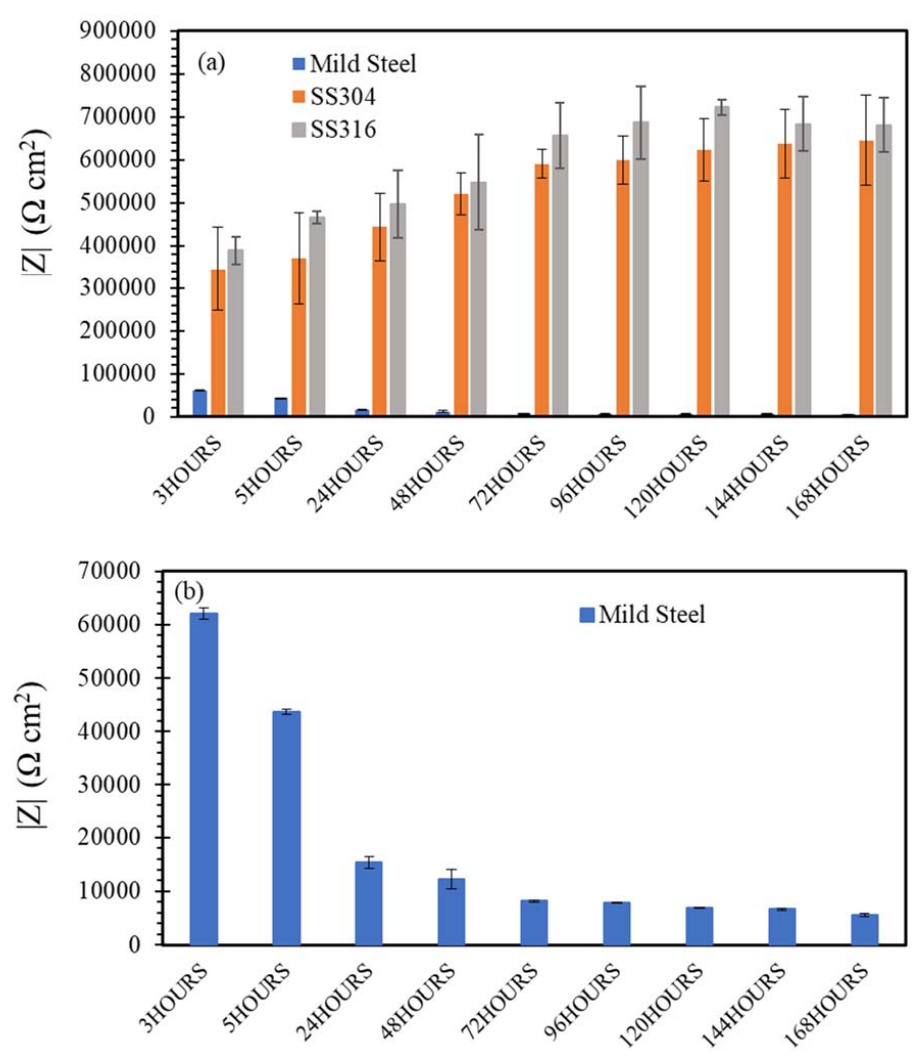
Figure 9. ( a , b ) Evolution of impedance |Z| for of mild steel, SS304 and SS316 in SW solution.